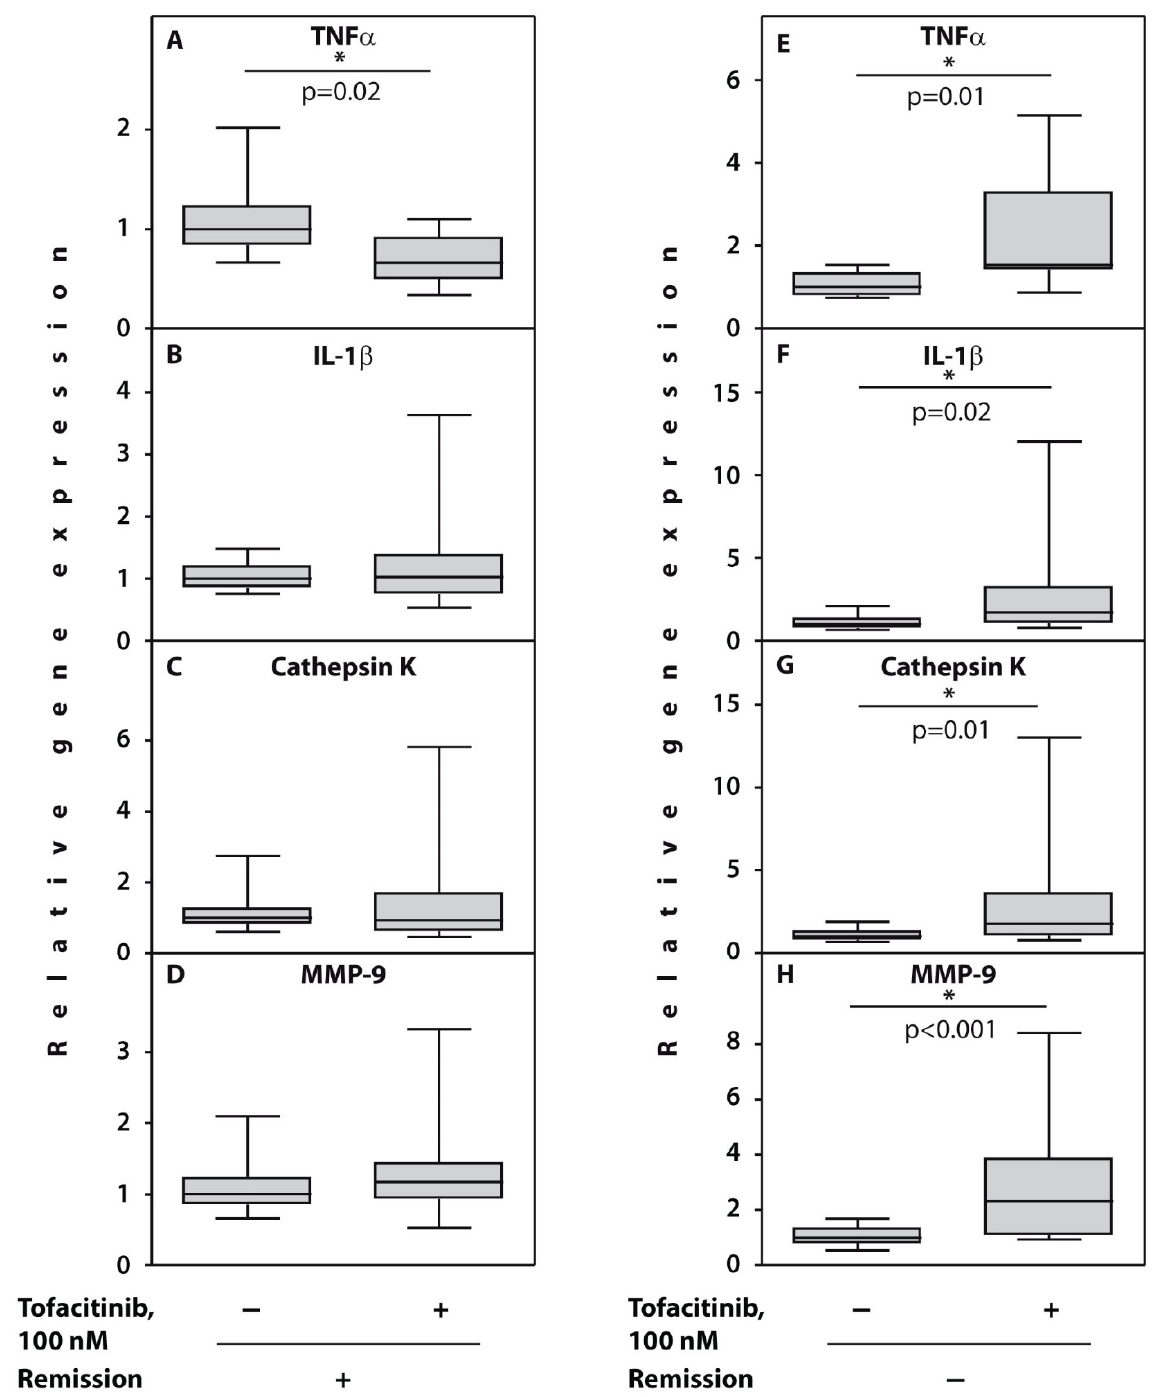
Figure 1. Relative gene expression in PBMCs from patients with RA prior to therapy cultured with tofacitinib during 48 h. ( A – D ) patients who gained remission ( n = 6); ( E – H ) no remission ( n = 6) was observed. Asterisks (*) indicate significant differences from control cells cultured without TFCN (Wilcoxon matched pairs test). Abbreviations: TNF α , tumour necrosis factor alpha; IL-1 β , interleukin 1 beta; MMP-9, metalloproteinase 9.